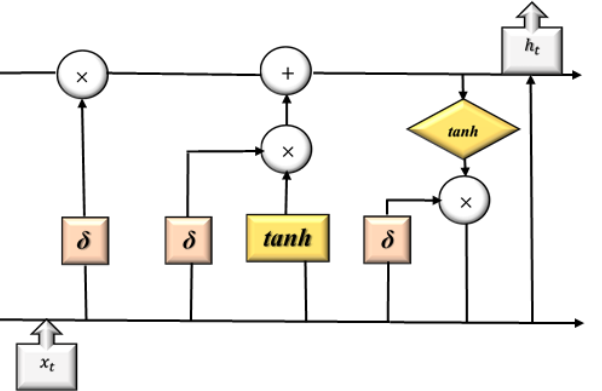
Figure 9. The long short-term memory (LSTM) cell block representation on how the input is processed within the architecture.